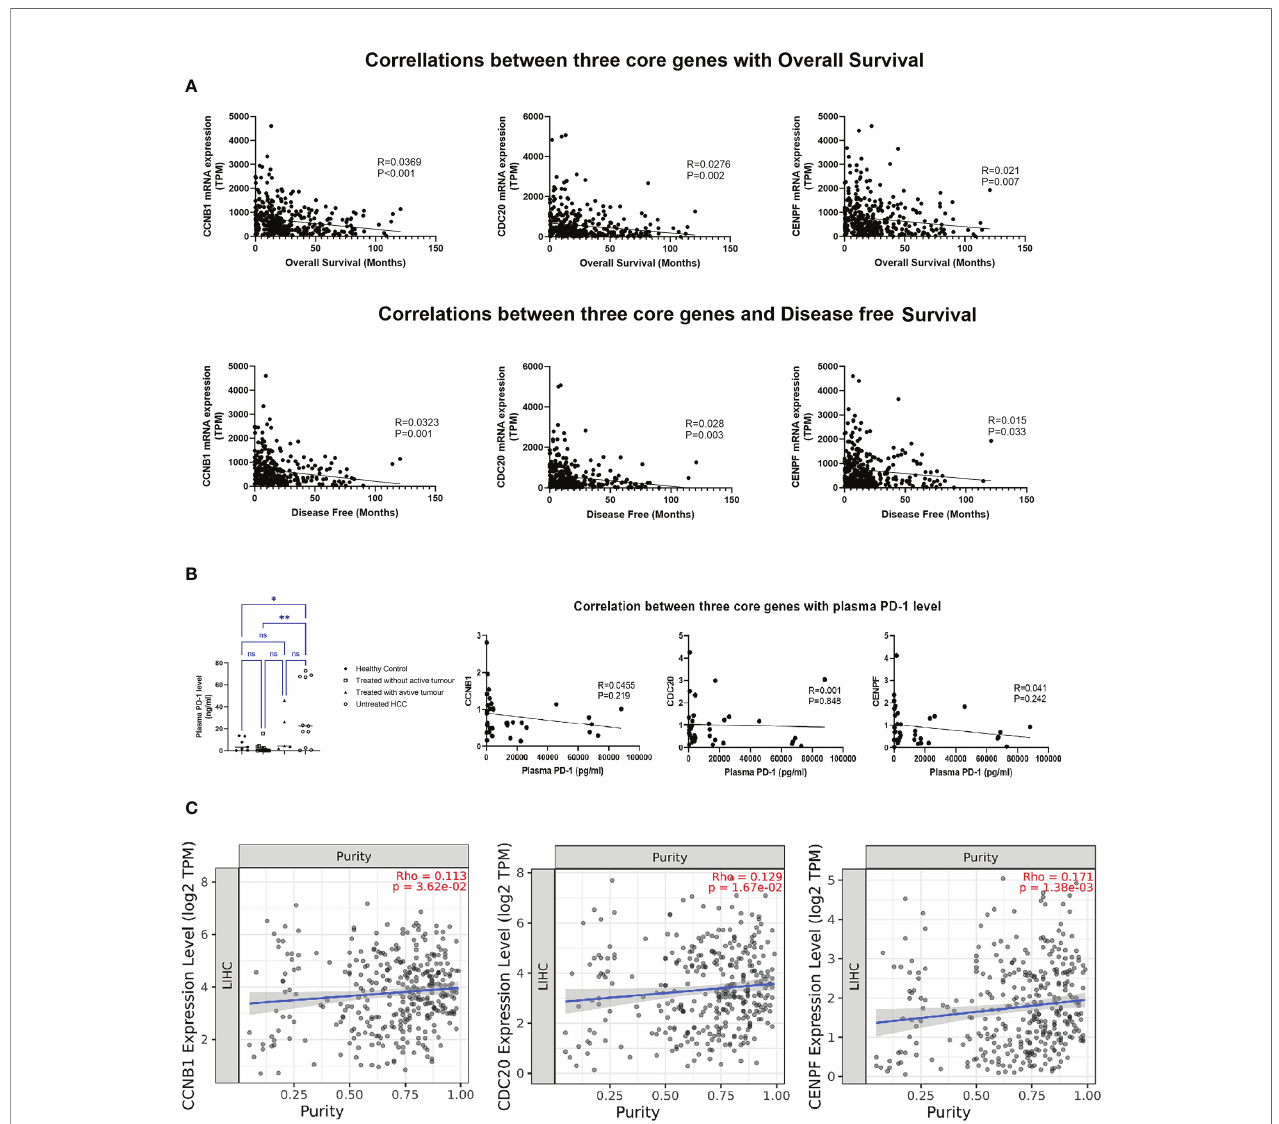
FIGURE 4 | Correlation analysis of three core genes: (A) Correlation with overall survival and disease-free survival. (B) Correlation with plasma PD-1 level. (C) Correlation with tumor purity in HCC. * P < 0.05, ** P < 0.01. ns, no signi fi